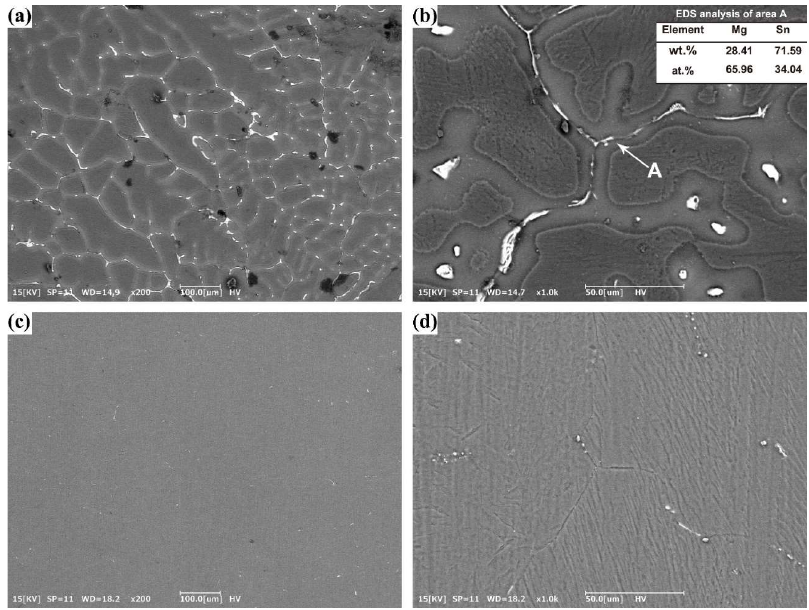
Figure 2. SEM images of ( a , b ) as-cast Mg-5Sn alloy; and ( c , d ) solid solution treated Mg-5Sn alloy. The inset in ( b ) is the result of EDS analysis of area A.